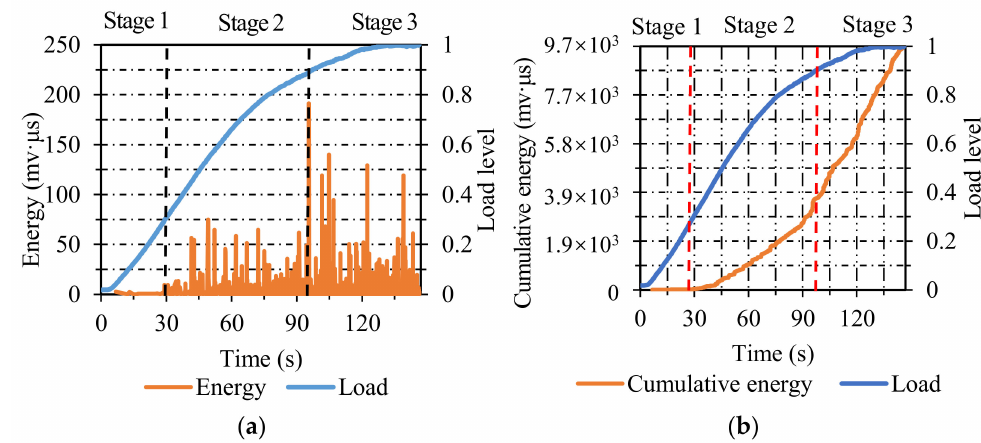
Figure 6. The energy and cumulative energy distribution of SMA: ( a ) energy; ( b ) cumulative